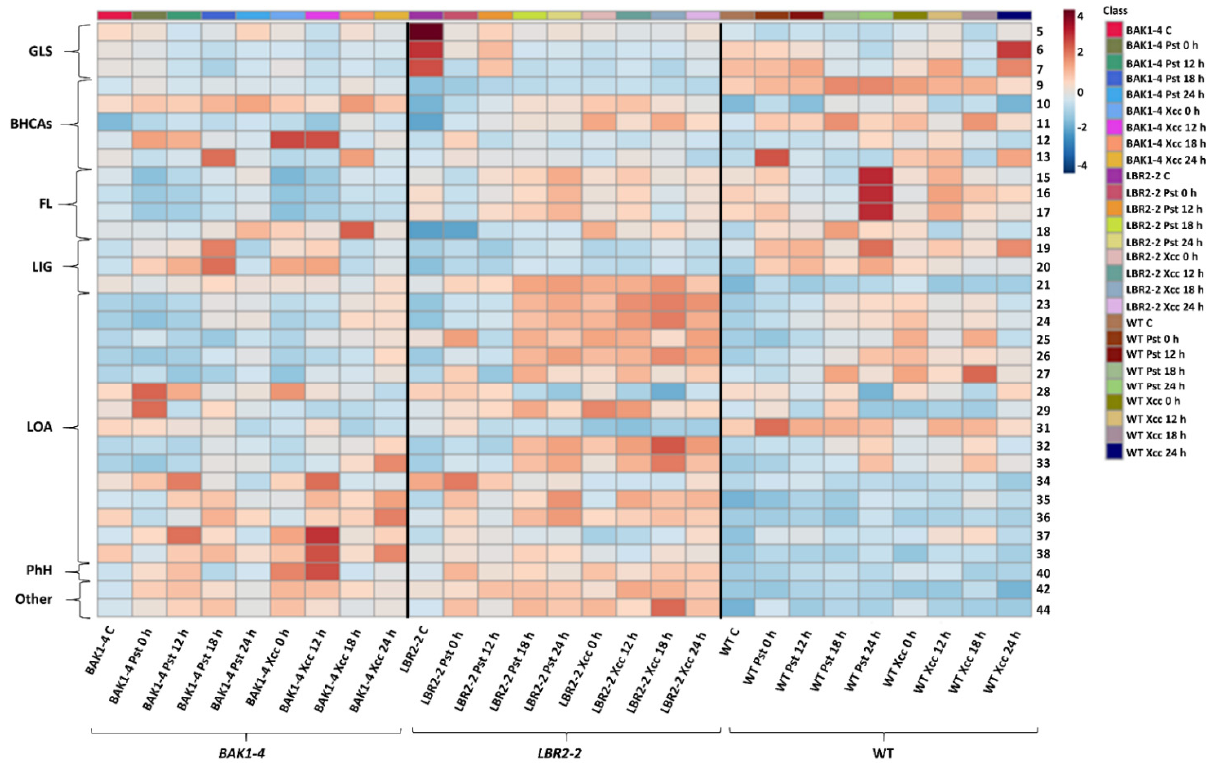
Figure 5. Heatmap presentation of significant annotated metabolites in ESI ( − ) mode. The LPS Pst – and LPS Xcc -induced annotated metabolites data of WT, lbr2-2 and bak1-4 were submitted to MetaboAnalyst and the relative intensities showing the extent of metabolites accumulation. The rows represent the group of the identified metabolites (numbered as in Table 1), while the columns represent Arabidopsis plants with their respective LPS chemotype time-related treatments. The colour gradient of dark blue indicates lowest intensity, while deep red indicates highest intensity. Metabolites are numbered as in Table 1. Abbreviations: GLS = glucosinolates; BHCAs = benzoic- and hydroxycinnamic acid derivatives; FL = flavonoids; LOA = lipids, oxylipins and arabidopsides; PhH =